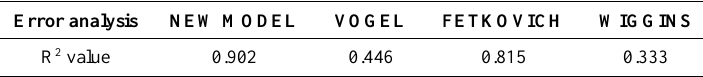
Table 1. Statistical analysis of results obtained for reservoir 1